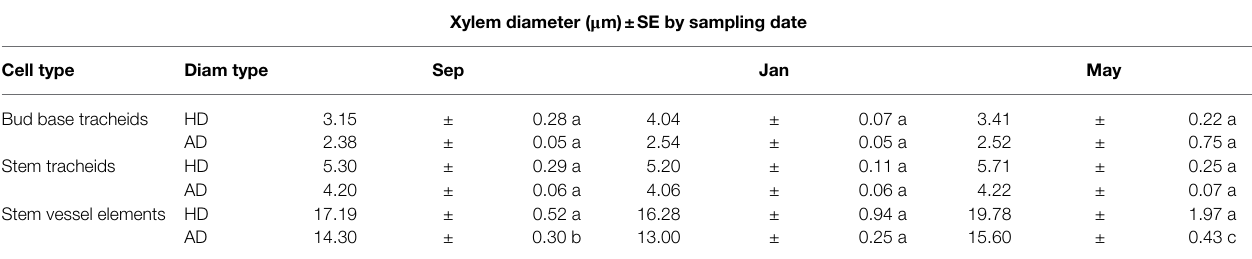
TABLE 1 | Arithmetic mean diameter (AD) and hydraulically weighted mean diameter (HD) of xylem conduits at the bud base and stem zones of Vaccinium macrocarpon .